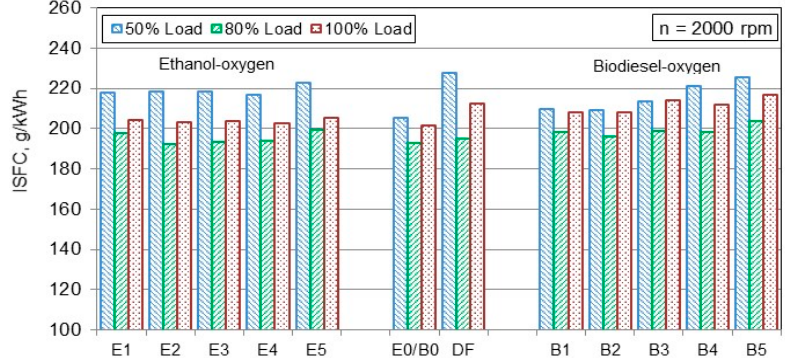
Figure 10. Indicated Specific Fuel Consumption (ISFC) as a function of ethanol–oxygen or biodiesel- oxygen mass content (wt%) in fuel blends for medium (50%), intermediate (80%), and full (100%) loads corresponding to the respective IMEPs of 0.75, 1.20, and 1.50 MPa, developed at maximum torque speed of 2000